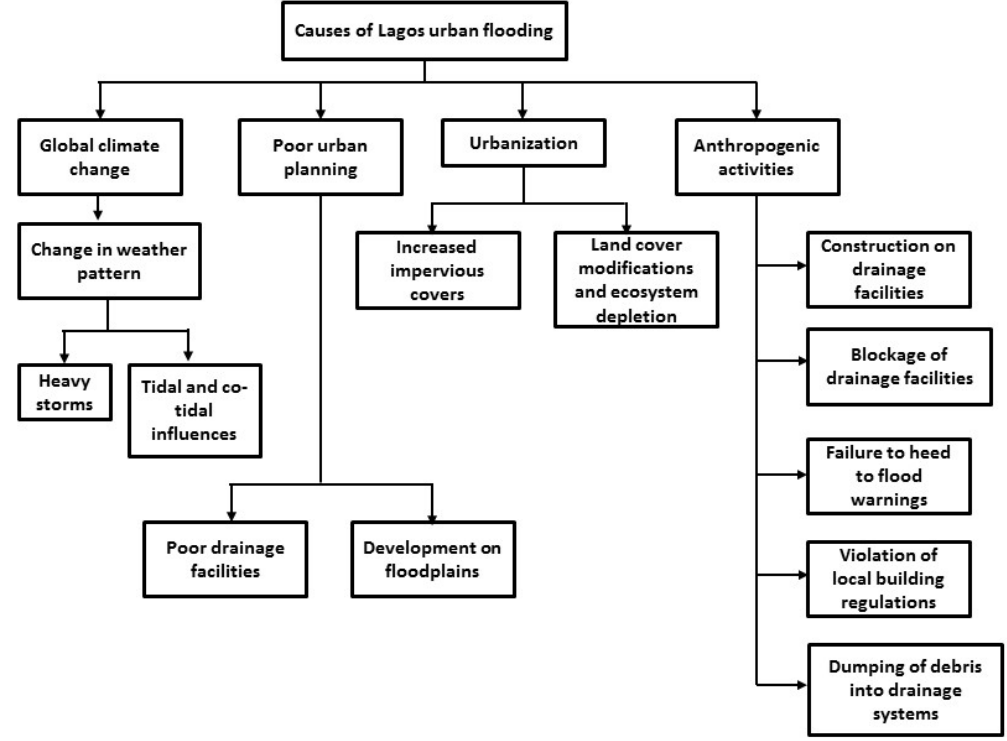
Figure 4. Main causes of urban flooding in the Lagos area of Nigeria showing global climate change, poor urban planning, urbanization, and anthropogenic